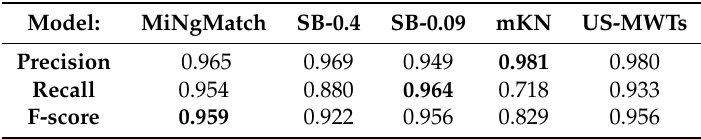
Table 15. SYOS: outputs of the best models re-evaluated against combined gold standard data